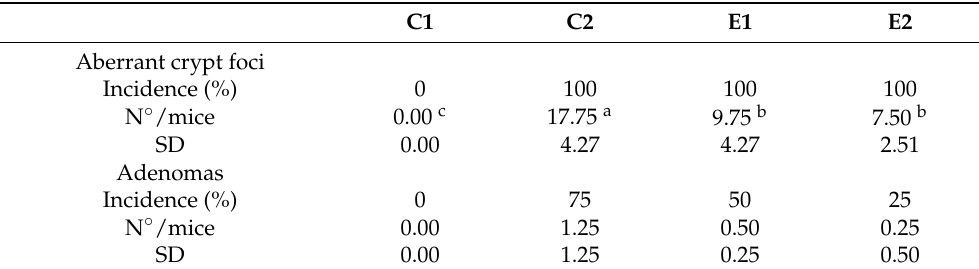
Values are mean and SD, n = 4 mice per group. Mean values within a row with unlike superscript letters